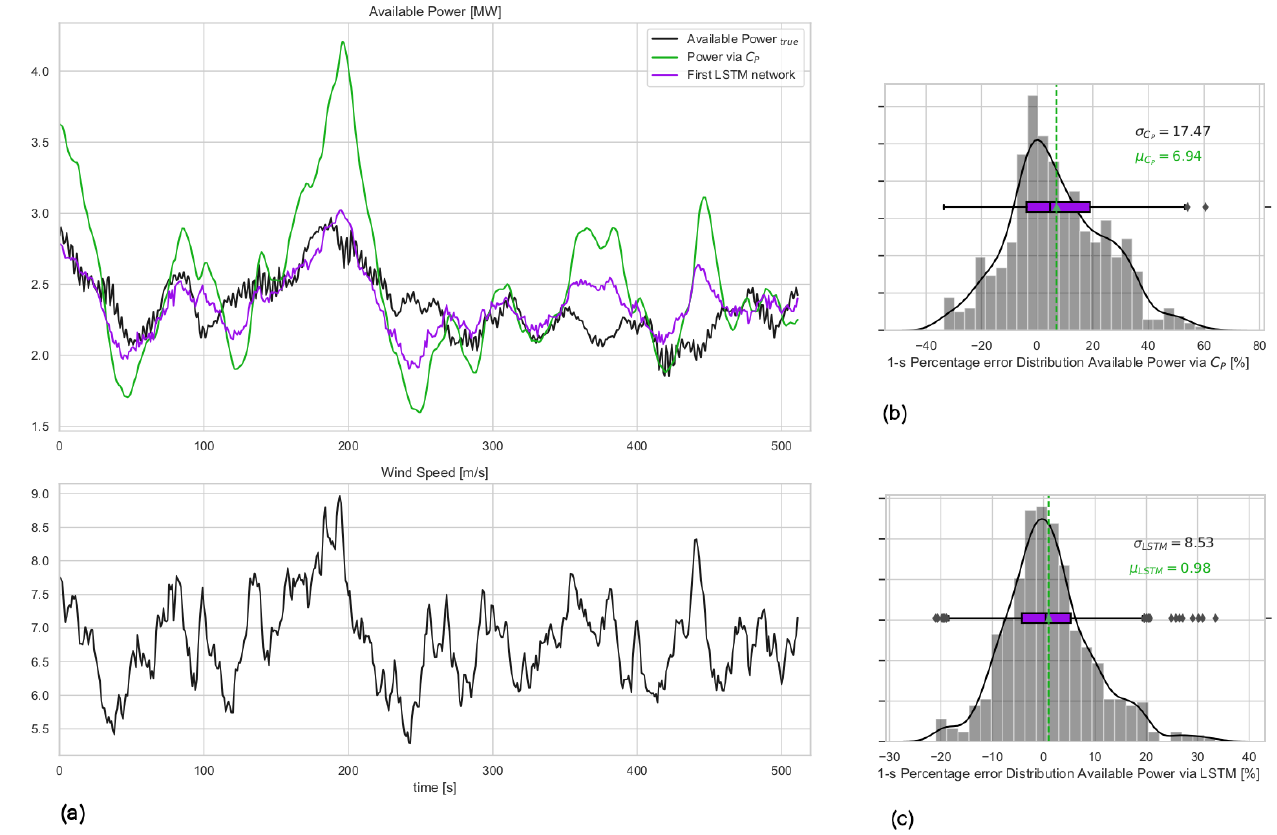
Figure 6. (a) The 1Hz time series of available power and wind speed for the first test case: second-wise comparison of the available power of the 10MW turbine for mean wind speed = 7ms − 1 and mean TI = 10% flow case represented in Fig. 4. (b) Available power estimation error via direct C P curve interpolation of wind speed; (c) error distribution of the first LSTM model with lag = 29s. µ and σ are the mean and the standard deviation of the 1Hz percentage error distributions.